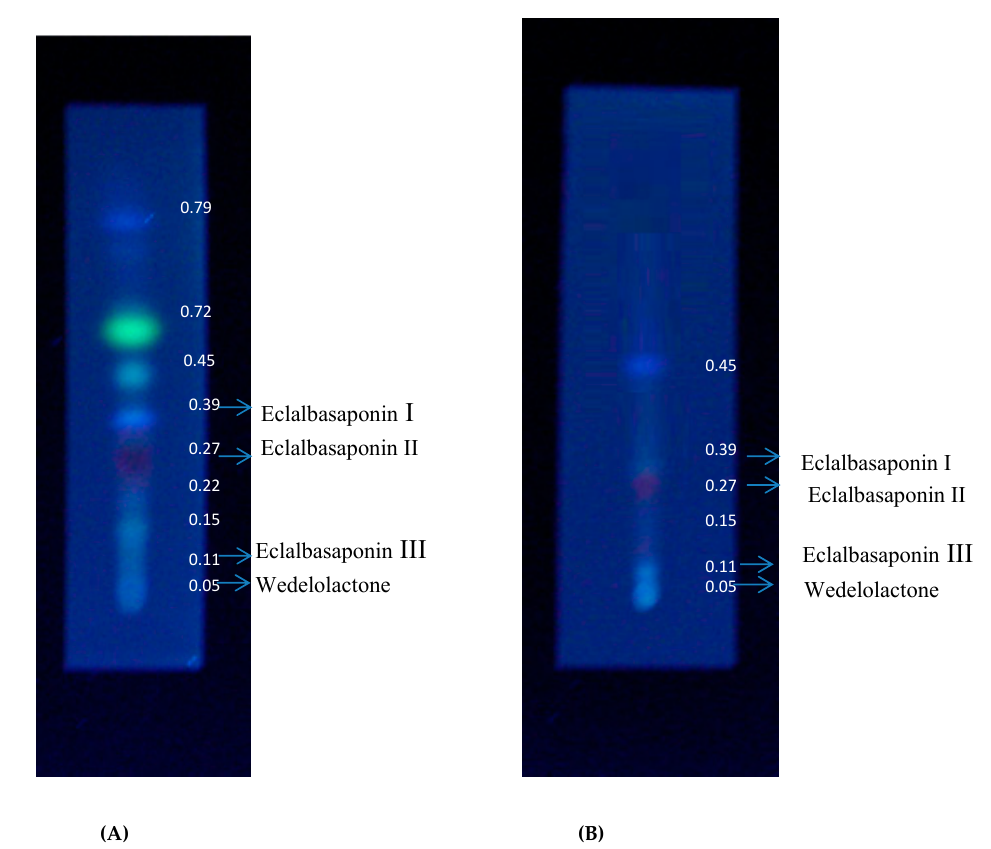
Figure 3. Thin layer chromatography (TLC) profile of E. alba ( A ) methanolic crude and ( B ) column purified extract.